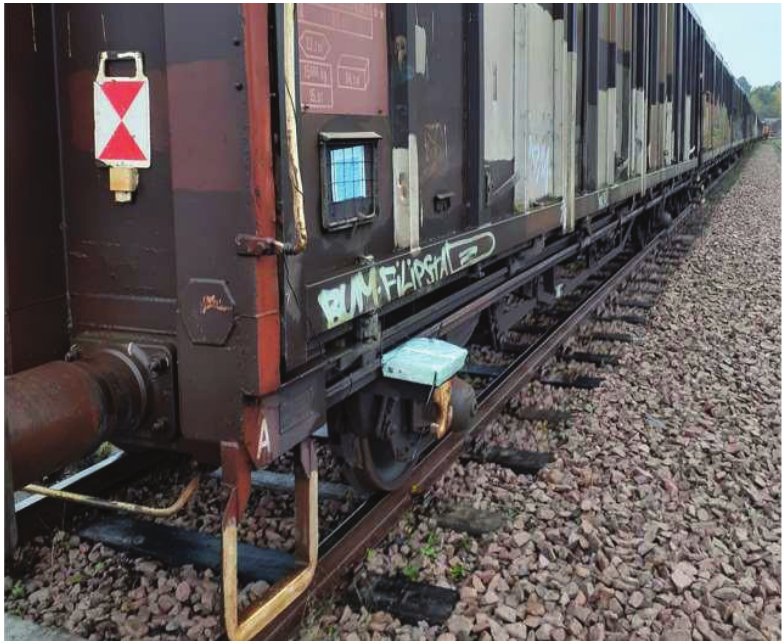
Figure 19. Placement of the nodes in the wagon.